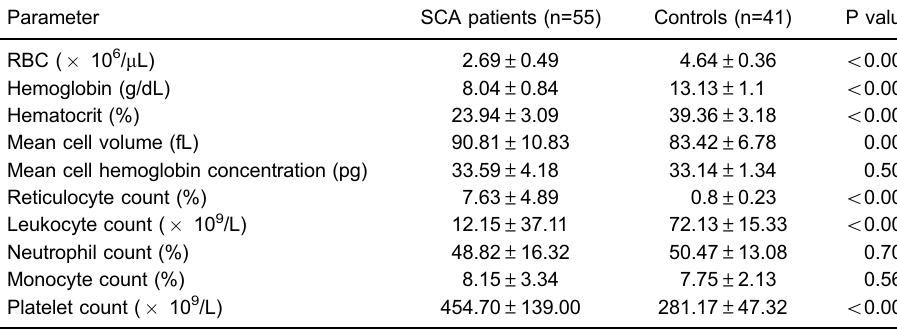
Table 2. Hematological characteristics of the study participants.